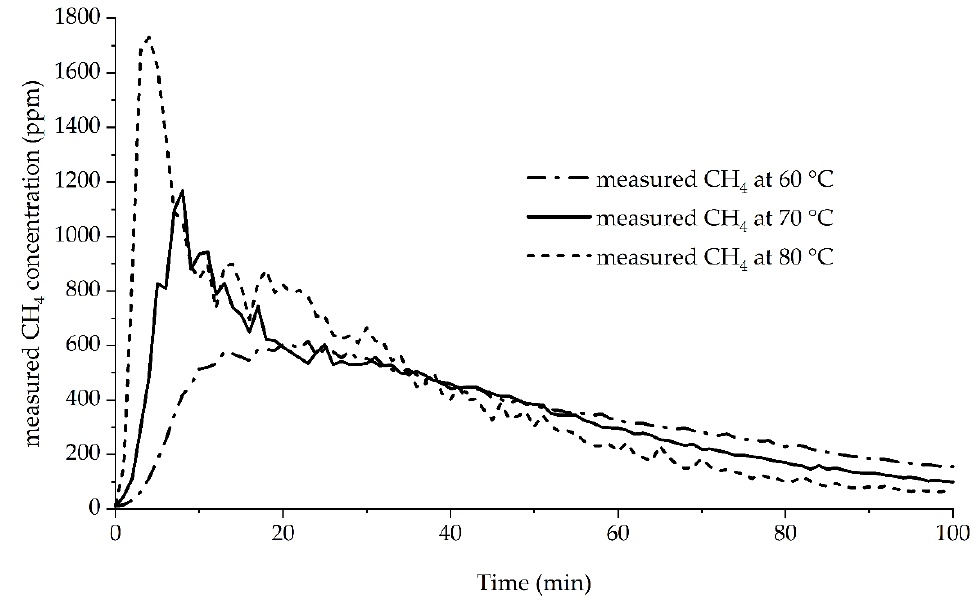
Figure 1. Mean CH 4 concentrations in the N 2 analysis stream (n = 3) in one-minute intervals for trials at the corresponding temperature from 0 to 100 min. The curves showed a steady decline to below 10 ppm after 100 min, and therefore, they are not shown.